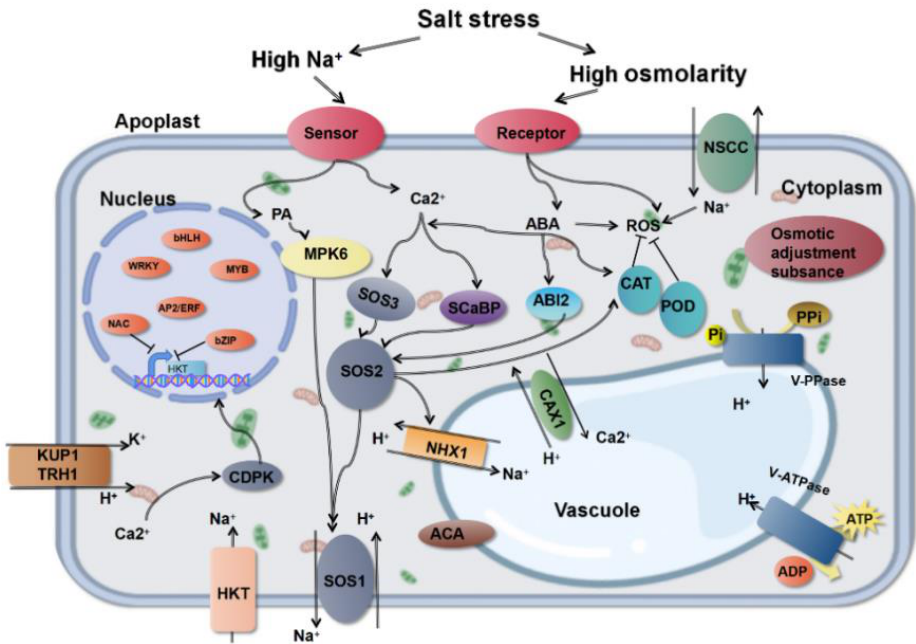
Figure 6. Important regulatory networks in response to salt stress in plants. Additional details are in the text.